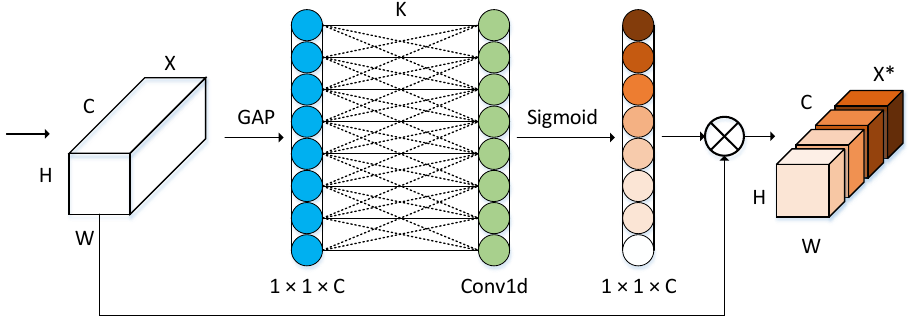
Figure 5. The structure of ECA.